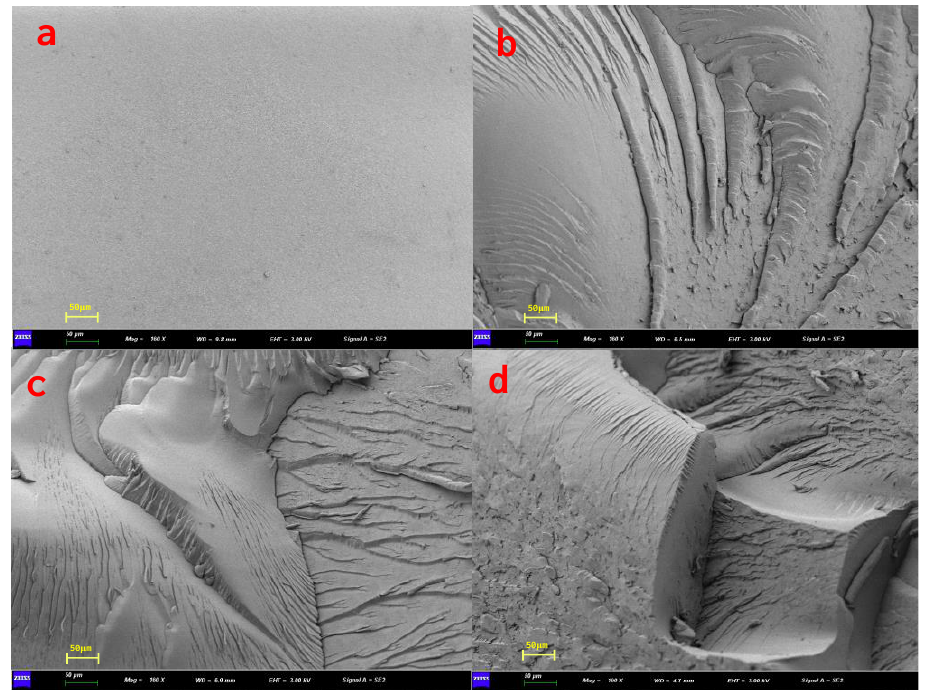
Figure 5. SEM micromorphology of the fracture surfaces of BMI-NH 2 . ( a ) BMI-0, ( b ) BMI-ODA, ( c ) BMI-FDA and ( d ) BMI-MT. ( c ) BMI-FDA and ( d )